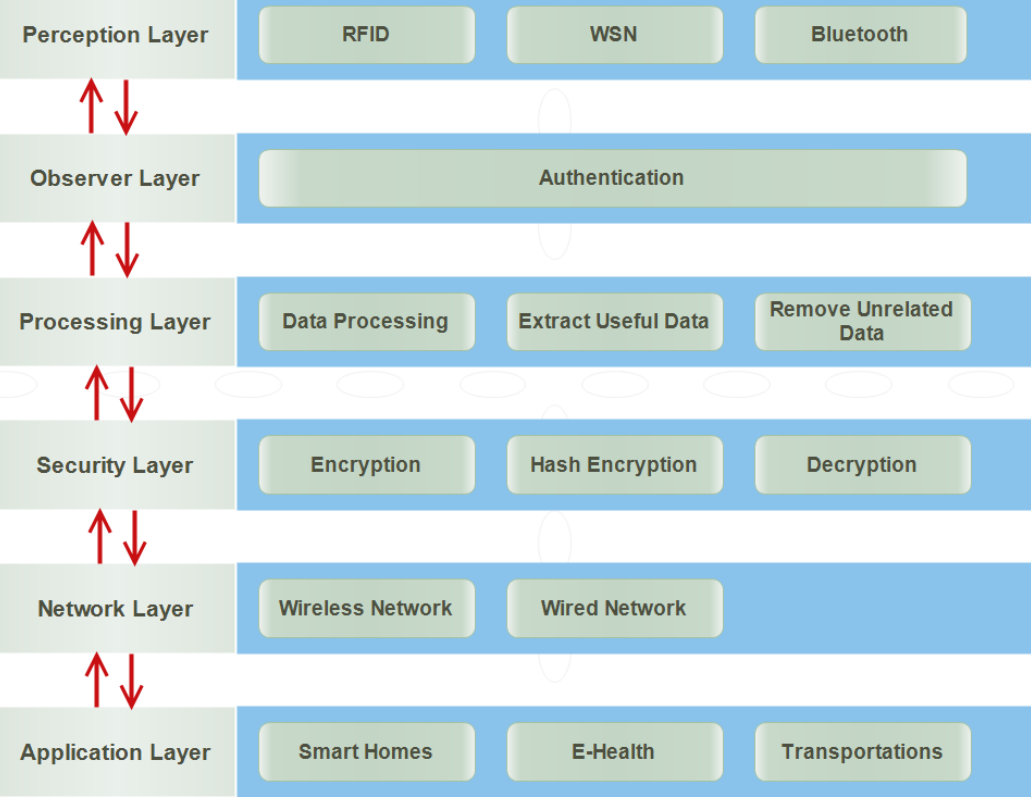
Figure 17. An improved layered architecture for